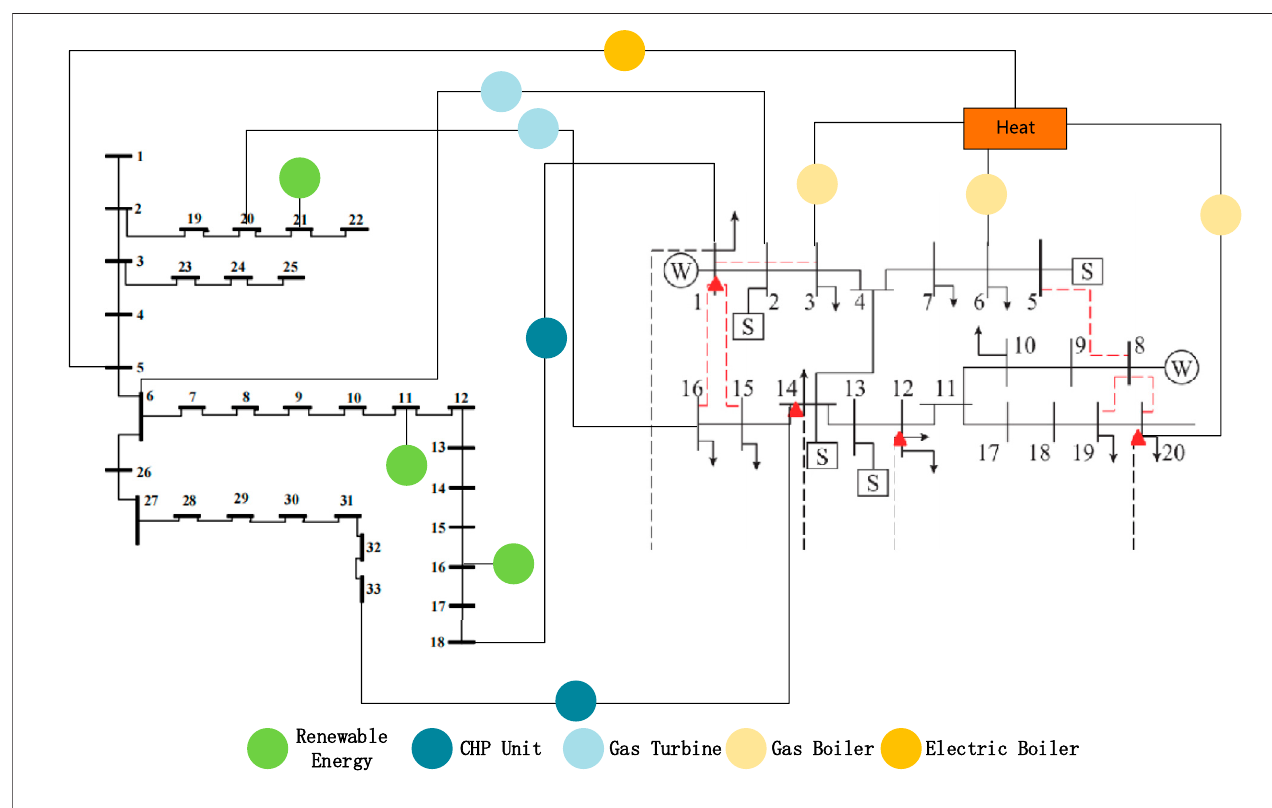
FIGURE 3 | Coupling network.